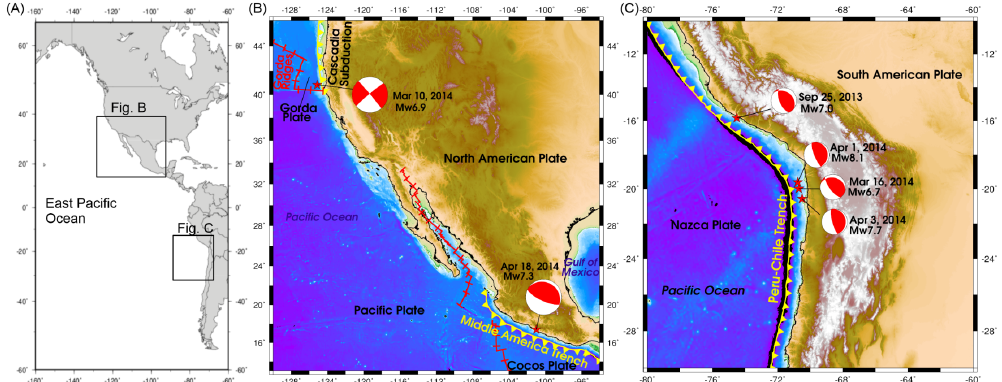
Figure 3. Earthquake events which occurred in the east Pacific source zone: (a) overview of the source zone; (b) location of the California and Mexico events (red stars), their focal mechanism: thrust faulting and strike–slip faulting, respectively (red beach ball), the subduction zone (yellow line) and the spreading centers (red lines); (c) location of four events: the Peru event and three events in northern Chile (red stars), their focal mechanisms are thrust faulting (red beach ball), and the subduction zone (yellow line).